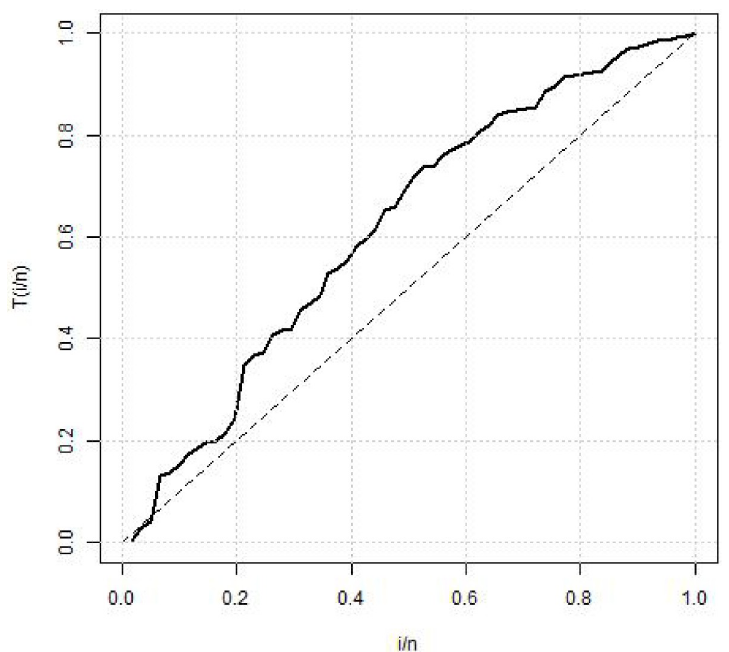
Fig 9. TTT plot of recidivism failure times data.